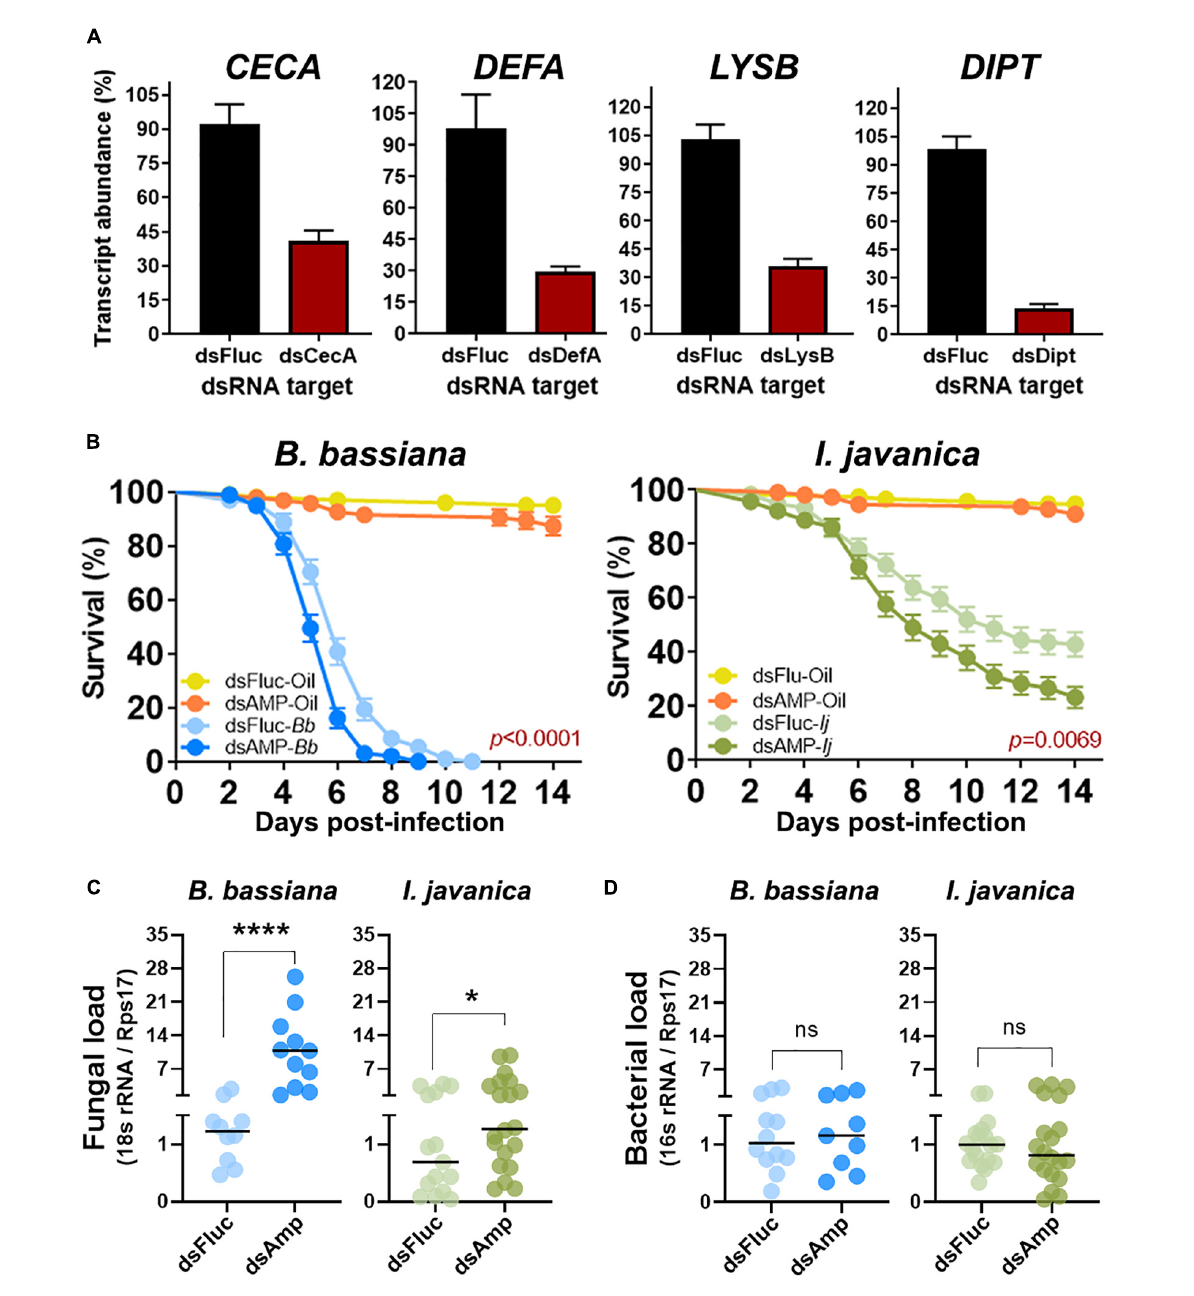
FIGURE4 Quadruple AMP knockdown increases fungal proliferation and decreases mosquito resistance to entomopathogenic fungi. (A) Silencing efficiency at 5 days post-silencing for CECA , DEFA , LYSB , and DIPT during quadruple knockdown assays. (B) Survival curves of mosquitoes infected with either B. bassiana or I. javanica following quadruple AMP knockdown. (C) Fungal loads and (D) bacterial loads at 5 dpi in mosquitoes infected with either B. bassiana or I. javanica following quadruple AMP knockdown. Survival curves represents at least four independent experiments and data was analyzed with Log-rank Test (GraphPad Prism 9). Fungal loads were determined from two independent experiments and the statistical significance was determined on log 2 -transformed values via T -test. Error bars indicate the SEM. * P < 0.05, **** P < 0.0001, ns, not statistically